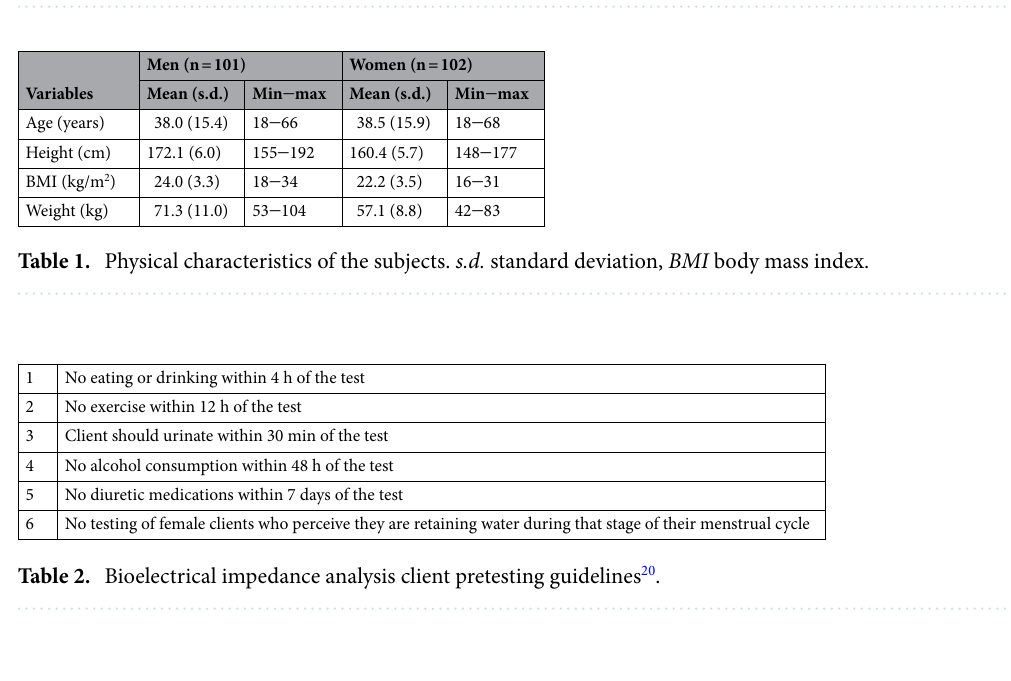
Figure 6. Measurement procedure and corresponding graphical user interface of the wrist-wearable bioelectrical impedance analyzer.